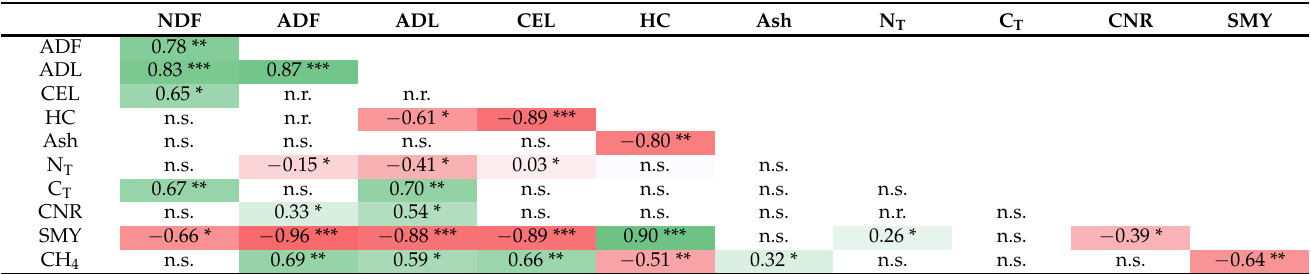
Table 5. Pearson’s correlation coefficients matrix of substrate-specific biochemical compositions and the key parameters of the biogas batch test. The levels of significance are indicated by asterisks. Significant Pearson’s correlation coefficients were colorized to emphasize negative (dark red) and positive values (dark